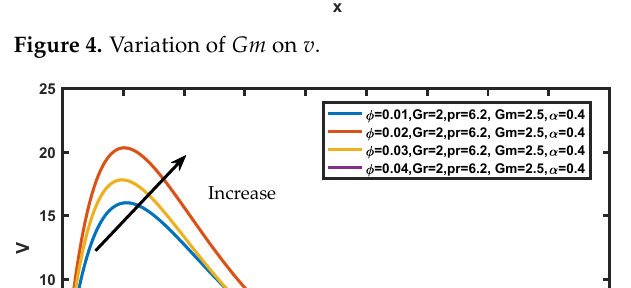
Figure 4. Variation of Gm on v .